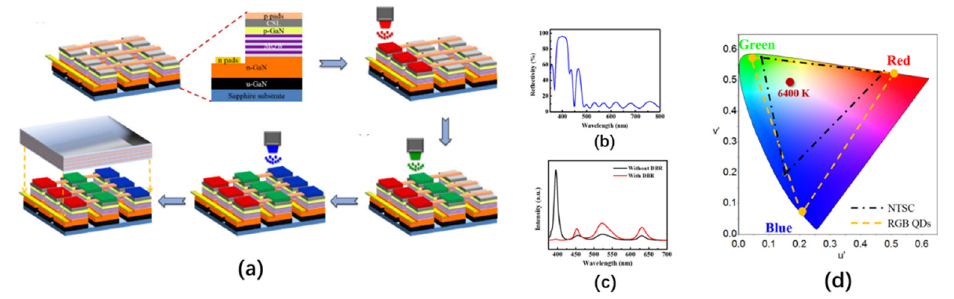
Figure 10. ( a ) Quantum dots (QDs) printing process; ( b ) distributed Bragg reflector (DBR) reflection spectrum; ( c ) emission spectrum with and without a DBR structure; ( d ) the NTSC CIE 1976 color space chroma diagram. Reproduced from [71], The Optical Society, 2012.